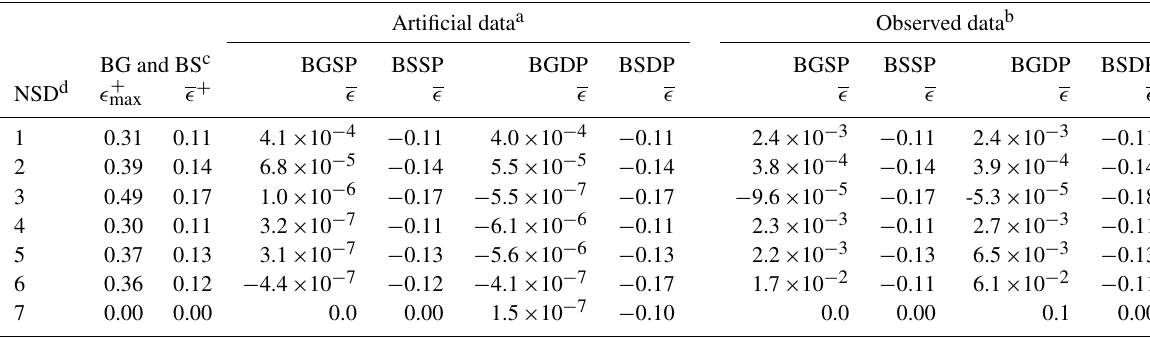
Table 3. Error metrics for Bit Grooming vs. Bit Shaving. Artificial data a Observed data b